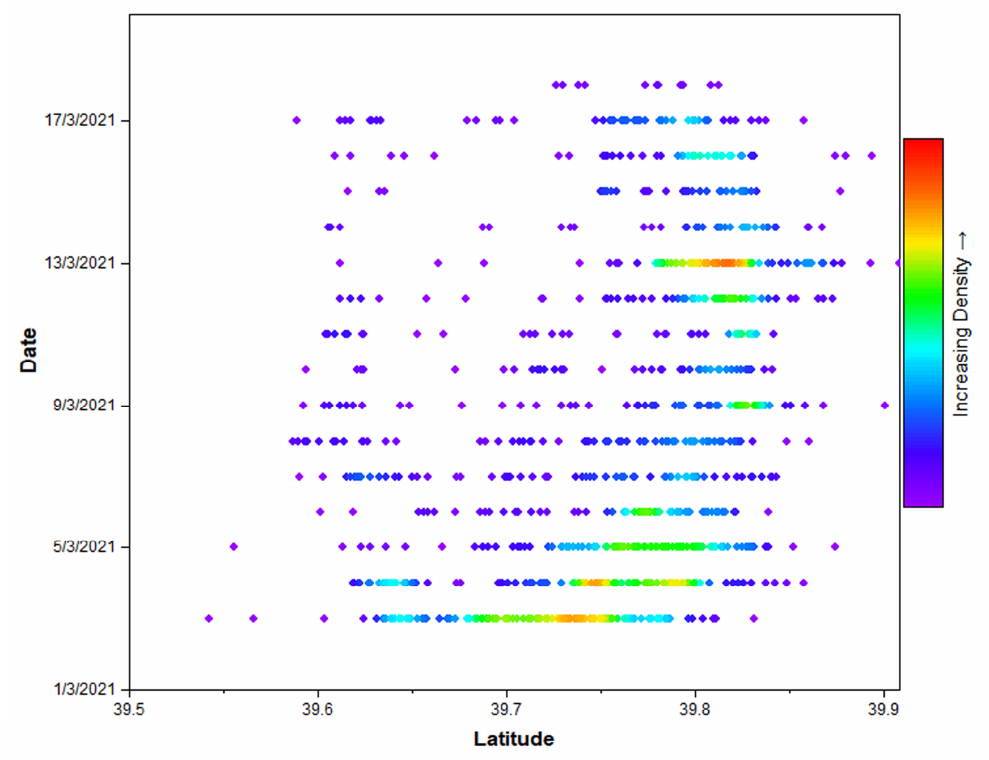
Figure 14. Spatial distribution (latitude) of earthquake density for different dates. We determined deviatoric moment tensor solutions for 34 earthquakes with M w ≥ 4.0 at depths between 6 and 14 km. The depths decreased in the eastern and especially in the western termination of the sequence. The proposed methodology’s application gave rise to the activation of normal faulting with the direction N-S. The depth varied 11 km < d < 15 km for the five strongest sequences, a fact that agrees with the study in [67], while the magnitudes were 5.2 < Μ w < 6.3. Here, they were concentrated at approximately 7 km in depth, in contrast to about 14 km in the central part of the sequence. The aftershocks oc- curred along the entire surface rupture length but mainly north. A very high percentage of a double couple (DC) in relation emerged to the compensated linear vector dipole (CLVD) for the most significant percentage of solutions. More specifically, 80% of the so- lutions presented a DC > 90% solution, while the remaining 20% had a DC between 75% and 89%. The focal mechanism solutions for the strongest earthquakes determined in this study appear in Figure 15.